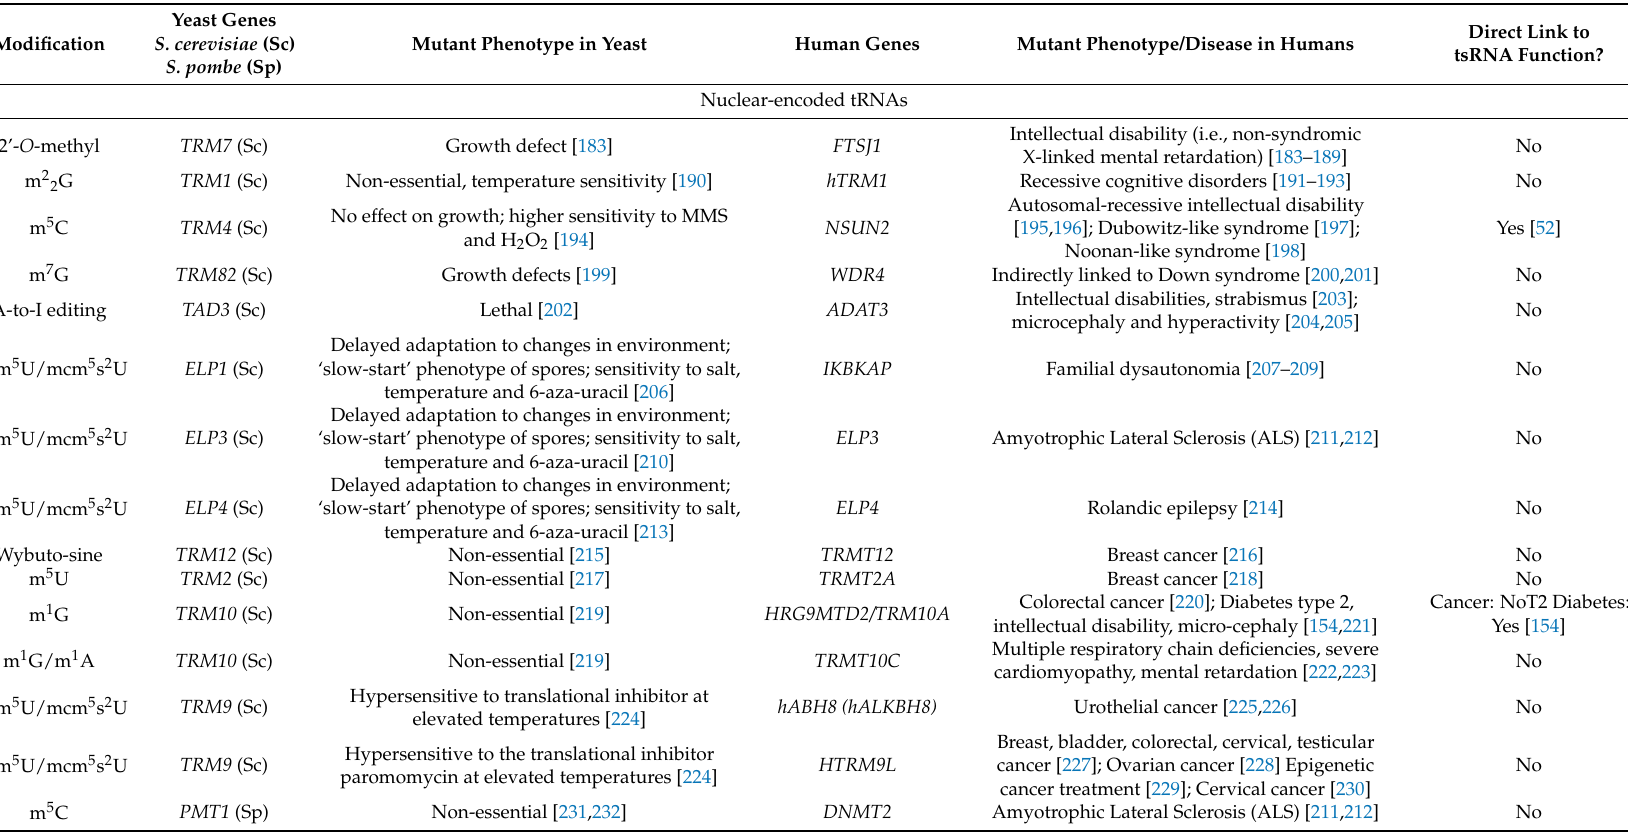
Table 2. tRNA modifications associated with human disease. Table depicts the connection between particular tRNA modifications, their knock-out models in yeast and the resulting mutant phenotypes and published associations between human orthologous genes and human disease syndromes. The last column states when a direct link to tsRNA activity has been made in